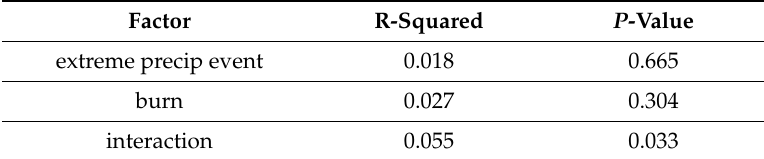
Table 2. Results from PERMANOVA analysis of bacterial community composition di ff erences as per burned / reference forest soils, before / after extreme precipitation event. Analysis based on Bray–Curtis distance among all